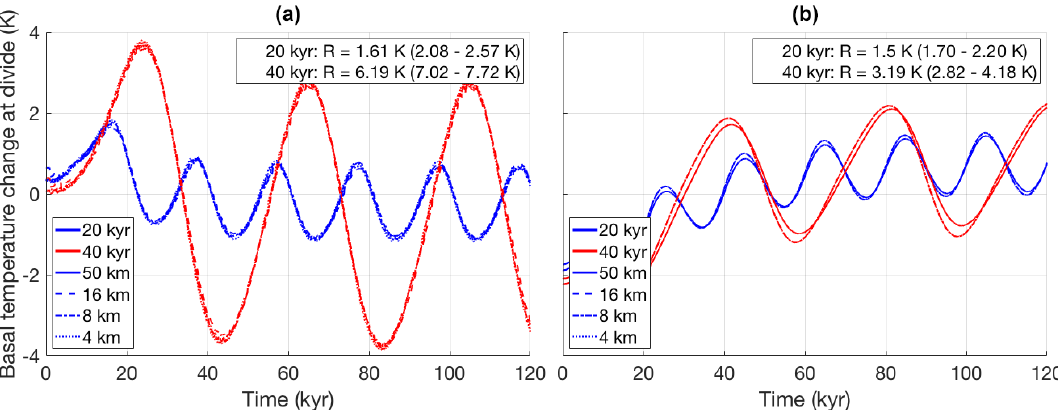
Figure 9. (a) Basal temperature change at the divide for experiments II and III (fixed margin, respectively 20 (blue) and 40kyr (red) sinusoid mass balance perturbation). (b) The same for the fixed margin experiments (V and VI), simulated by UFEMISM at 50, 16, 8, and 4km ice-margin resolutions. Listed in the top-right corners of both panels are the glacial–interglacial basal temperature changes simulated by UFEMISM, compared to the ranges reported by Huybrechts et al. (1996) between